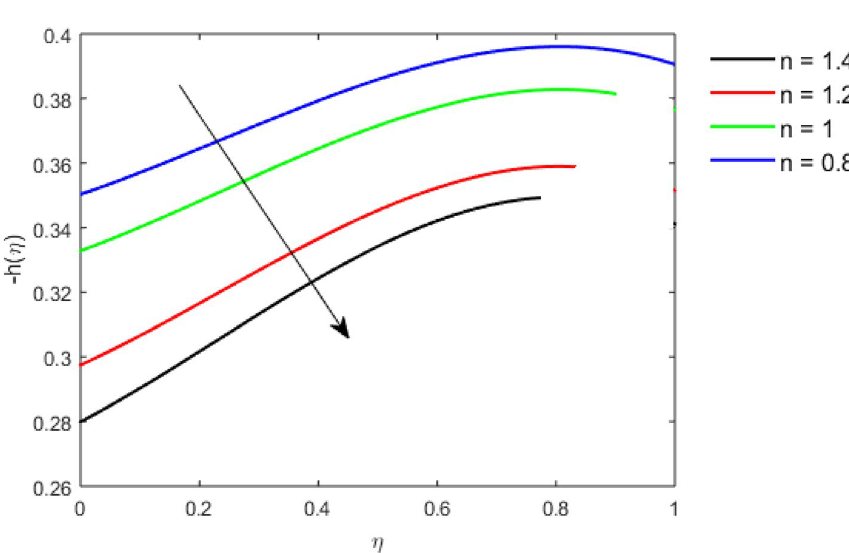
Figure 4. The Axial velocity profile for decreasing power-law fluid index with thickness index of disk m = 0.8, r = 0.6, Pr = 1